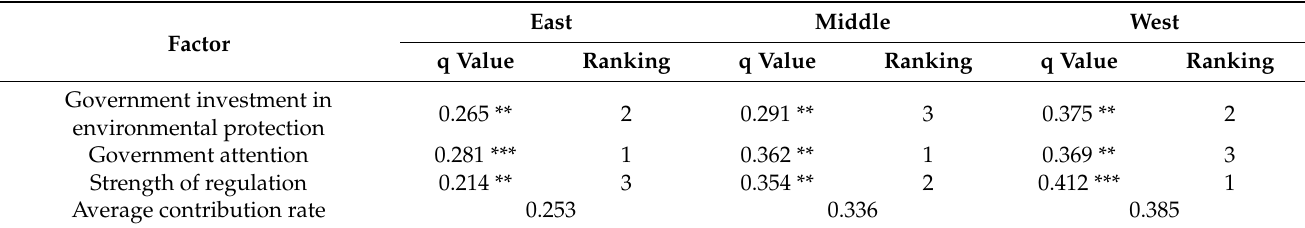
Table 4. Detection results of local ER